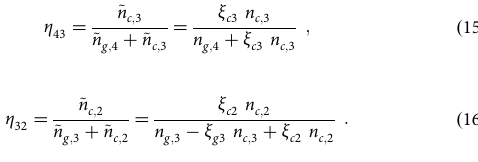
readout procedure (bottom). The “ CMOS ” line shows the exposure periods of the CMOS camera accumulating the fl uorescence signal at 410 nm. clock 4-3 and clock 3-2 pulses are the π -pulses that transfer the population from the upper clock levels to the ground levels.